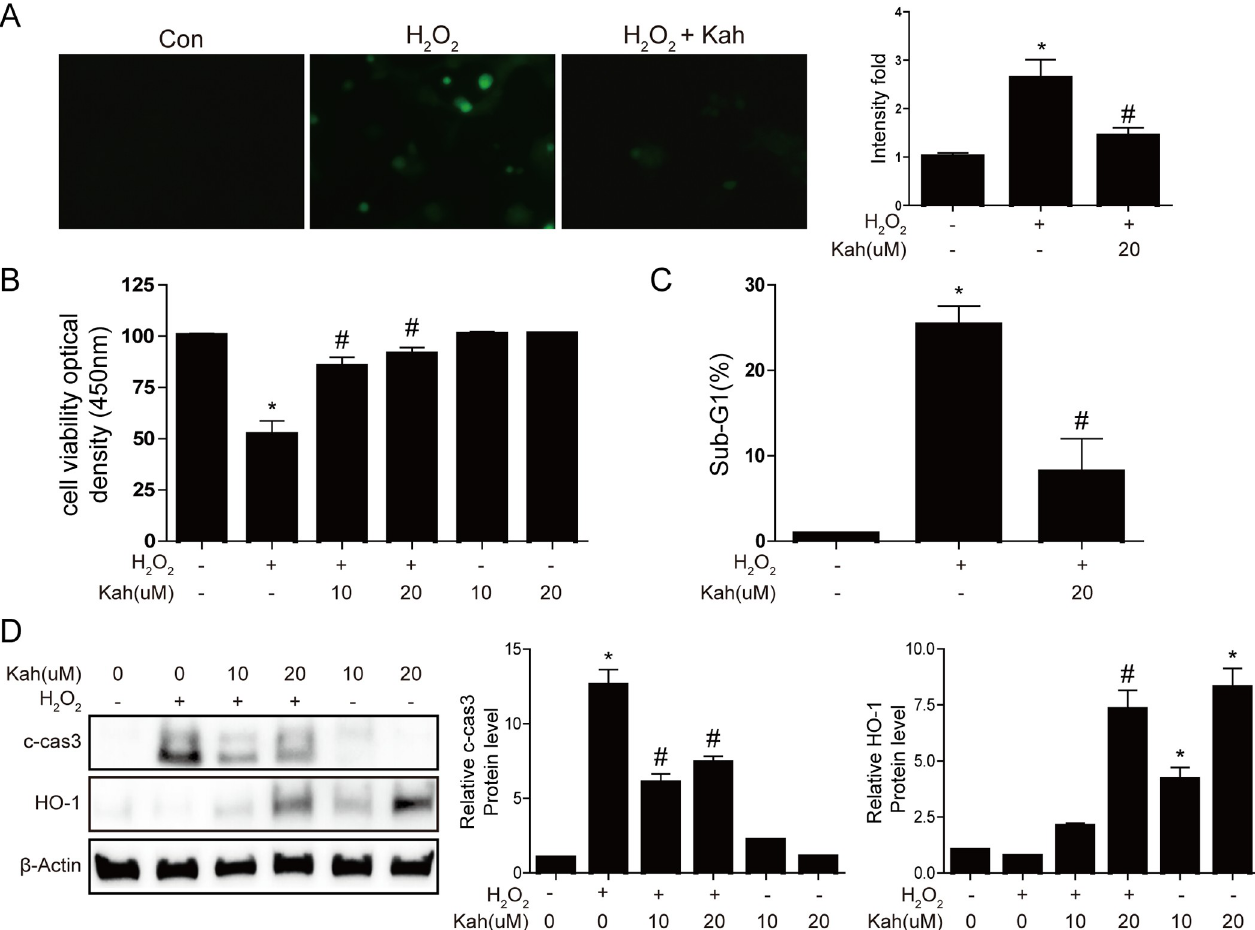
Fig 1. The effects of kahweol on H 2 O 2 -induced oxidant stress in hepatocytes. AML12 cells were treated with kahweol (10 or 20 μ M) for 19 h and then incubated with H 2 O 2 (1mM) for a further 5 h. ( A ) DCF-DA staining of cells treated with 1 mM H 2 O 2 and with or without 10 μ M kahweol. Data in the bar graph are means ± SEM of three independent measurements. � p < 0.05 compared with the control, # p < 0.05 compared with the H 2 O 2 treatment. (B) The viability of AML12 cells treated with or without H 2 O 2 and kahweol, as determined by a CCK-8 assay. (C) FACScan flow cytometry analyses of AML12 cells treated with or without H 2 O 2 and kahweol. Apoptosis was determined based on the sub-G1 population. ( D ) Western blot analyses of cleaved caspase 3 and HO-1 levels in AML12 cells treated with or without kahweol (10 or 20 μ M) and 1 mM H 2 O 2 . � p < 0.05 compared with the control, # p < 0.05 compared with the H 2 O 2 treatment. Con, control; Kah,